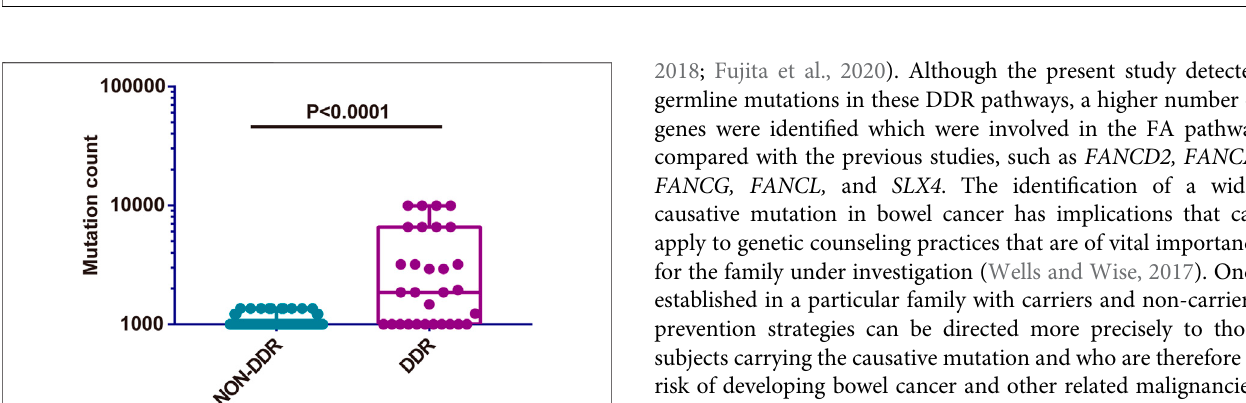
FIGURE 6 | The proportion of the detailed DDR pathways (A) and the number of patients with speci fi c DDR pathway genes in TCGA (B). TCGA: The Cancer Genome Atlas; DDR: DNA damage response.